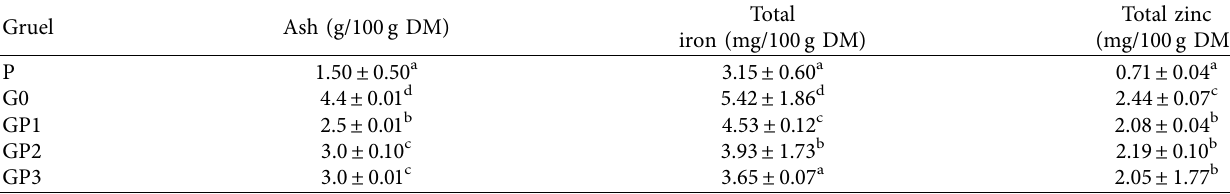
Table 4: Ash, total iron, and total zinc contents of mashed sweet potato and fortifed gruels. Gruel